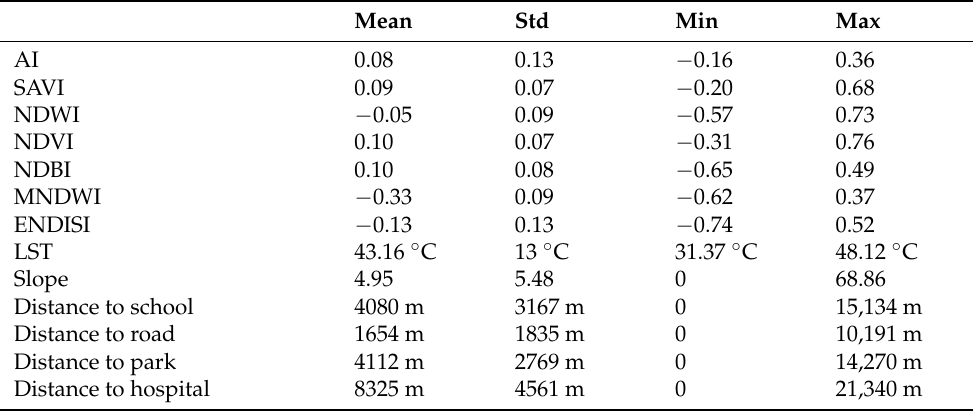
Table 3. Descriptive statistics of biophysical and infrastructure facility indicators for Al Ain city.